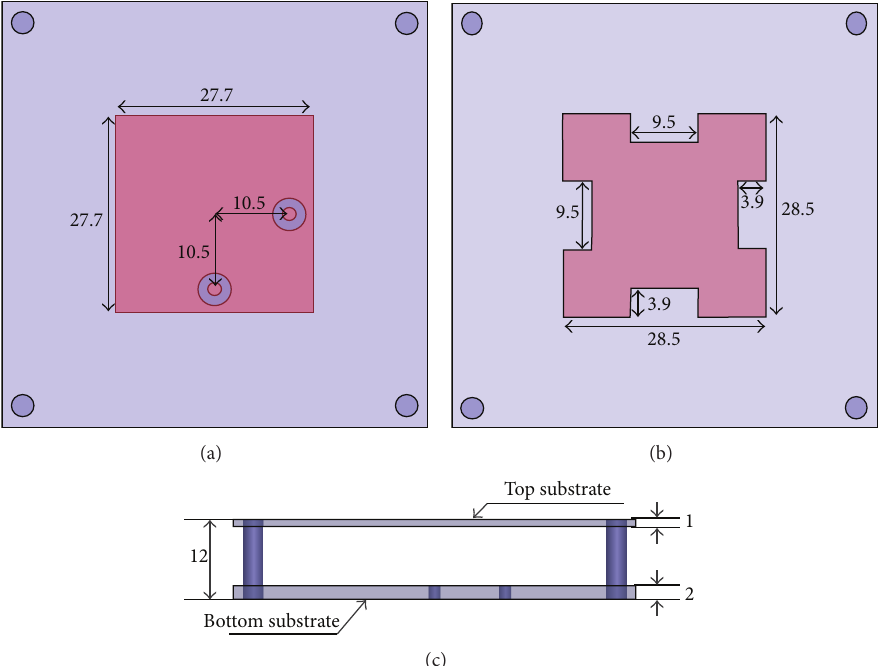
Figure 2: Configurations of the stacked microstrip antenna. (a) Top view of bottom layer. (b) Top view of top layer. (c) Side view (all units are in